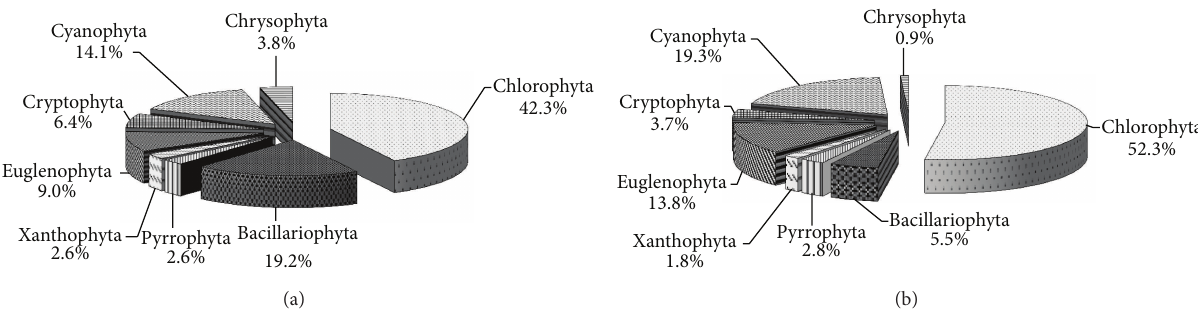
Figure 2: Composition percentage of the main phytoplankton in the study area in spring (a) and summer (b).